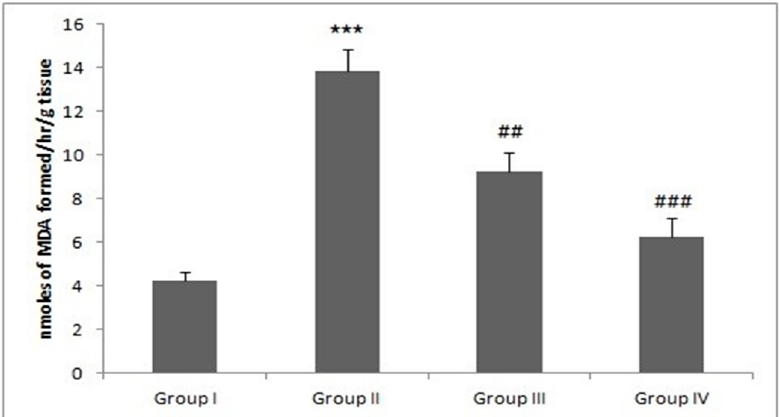
Figure 6. Piperine treatment alleviates MDA levels. In DMH-administered / tumor group-II, the MDA level was increased significantly ( *** p < 0.001) as compared to control group. Treatment with piperine (30 and 60 mg / kg b. wt.) significantly alleviated MDA levels in group III ( ## p < 0.01) and group